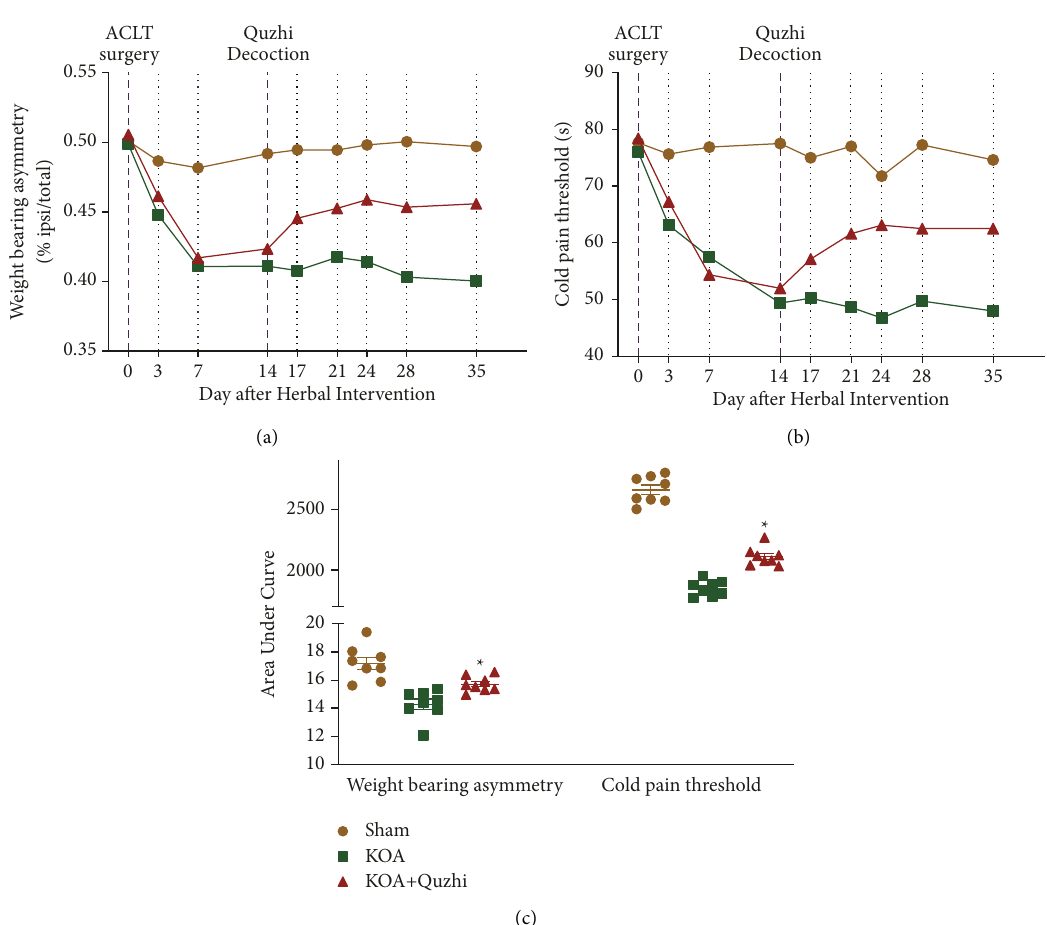
Figure 2: Quzhi decoction attenuates pain-like behavior in knee OA rats. At days 0, 3, 7, 14, 17, 21, 28, and 35 post-ACLTsurgery, weight- bearing asymmetry was determined by an in-capacitance tester. (a) The results were calculated as weight borne on the ipsilateral hindlimb as a percentage of total weight borne (dextral weight borne/(dextral weight borne +sinistral weight borne) × 100); (b) cold pain threshold testing was performed on a cold plate (35150-001, Ugo Basil SLR, Italy) with a temperature of 0 ± 3 ° C; (c) the area under the curve of weight- bearing asymmetry or cold pain threshold from day 0 to 35 was also calculated. The results are expressed as the mean ± SEM. N � 8, ∗ p < 0 . 05. OA